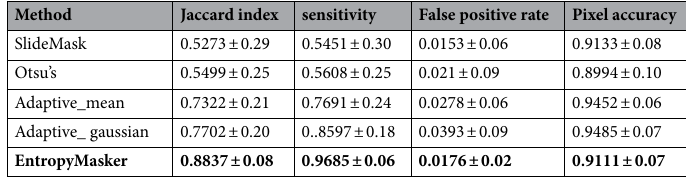
Table 1. Comparison of different masking methods. The method with the highest evaluation metric is shown in bold. Metric values represent mean ± SD.